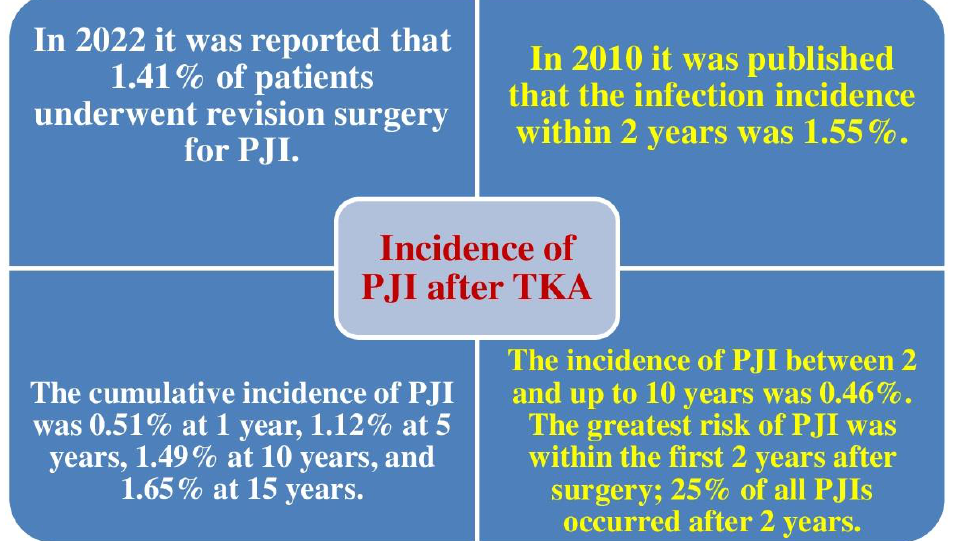
Figure 2. Rates of periprosthetic joint infection (PJI) after primary total knee arthroplasty (TKA) published in 2010 [20] and 2022 [11].